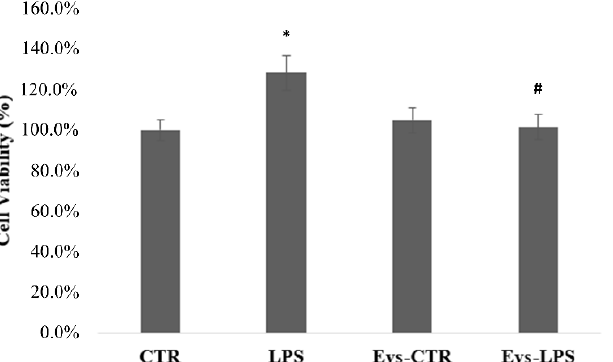
Figure 4. Analysis of BV2 cells proliferation evaluated by MTT assay. Histograms represent the percentage, with respect to control cells (CTR, 100%), of proliferating cells after the exposure to LPS, EVs-CTR, or EVS-LPS. (* p -value ˂ 0.05 compared to control cells; # p -value ˂ 0.05 compared to LPS). Data are expressed as the mean ± SD of three independent experiments.